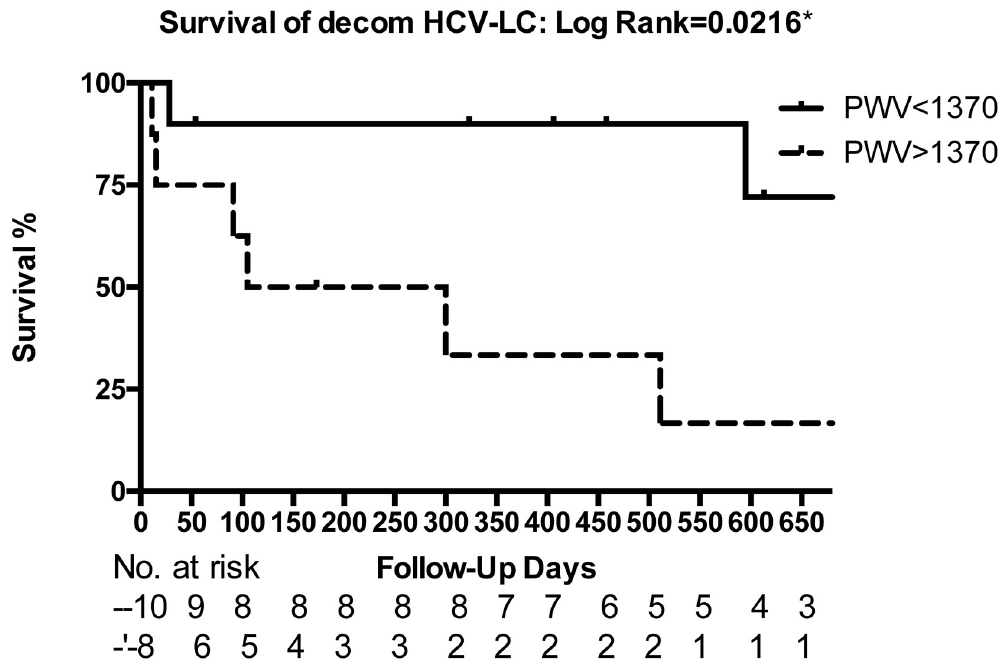
Fig 2. The Kaplan–Meier plot of one-point PWV > or < 1370 cm/s predicted mortalities of patients with HCV related decompensated cirrhosis (Log-rank test p = 0.0216). The number of patients at risk on each time point is also shown in the bottom of the